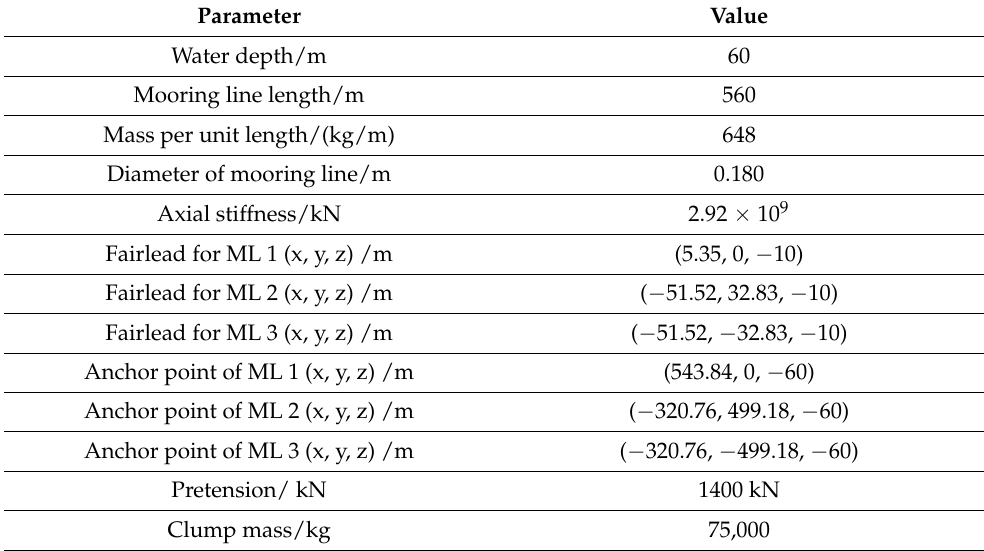
Table 3. Mooring line properties of WindFloat SFOWT.